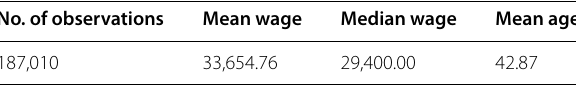
Source: own calculations, SOEP-Core.v37.EU, years 2001–2020 Wage: nominal annual wage in euro, mean over (median of) all observations of the sample. Age: mean age in years Only wages above the marginal earnings threshold are taken into account